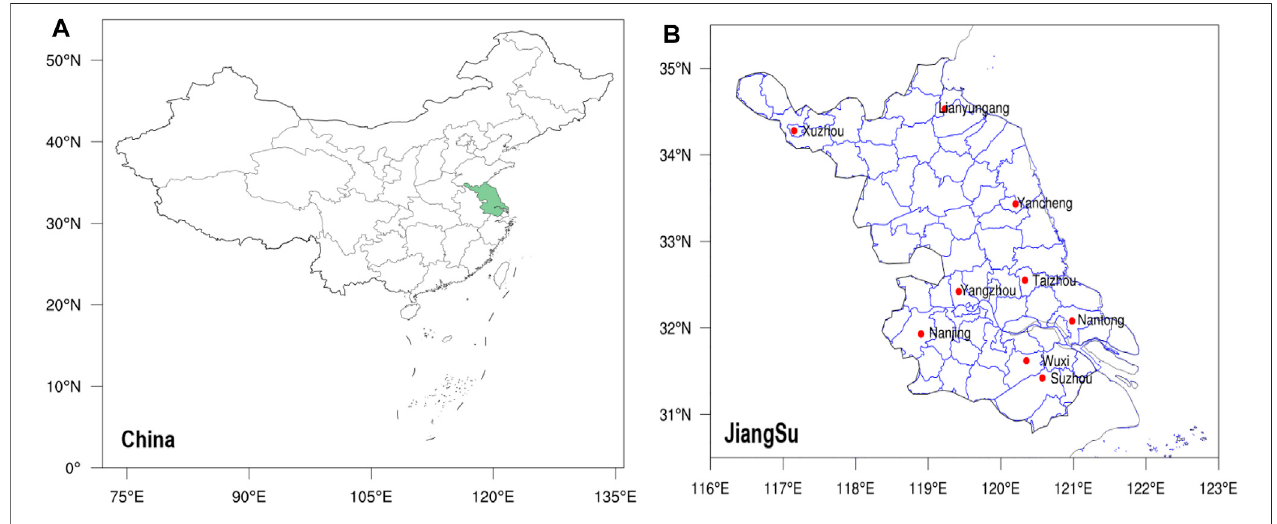
FIGURE 1 | Locations of the observation sites in Jiangsu province,